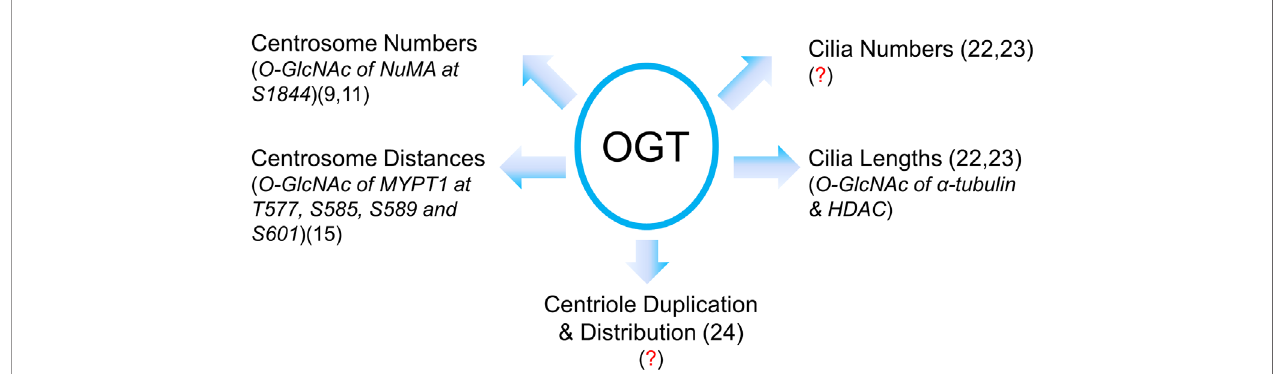
FIGURE 2 | A summary of our current understanding of OGT in centrosome biology in its infancy. Present literature suggests that OGT regulates centrosome numbers and distances, cilia numbers and cilia lengths, centriole numbers and distribution. However, due to the limited amount of proteins in the centrosome or cilia, identi fi cation of OGT substrates in these vestigial subcellular structures has been quite a daunting task. The known O-GlcNAcylated proteins with their modi fi cation sites are italicized with the proper references. Red question marks demarcate where mechanistic insights are still